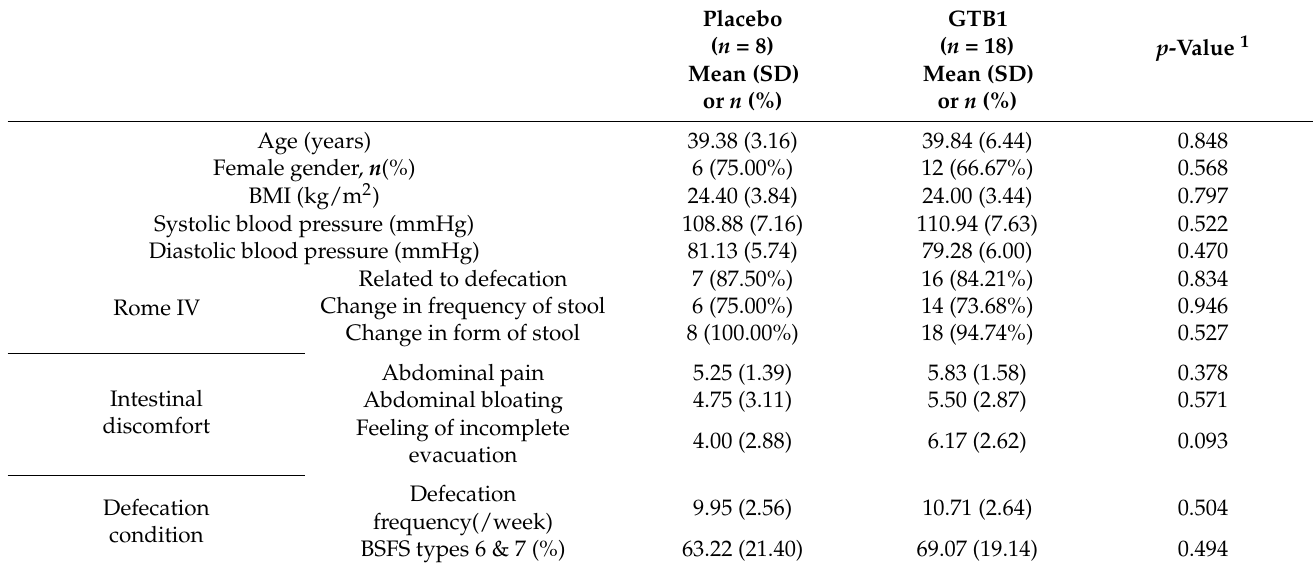
Table 1. Baseline demographics and clinical